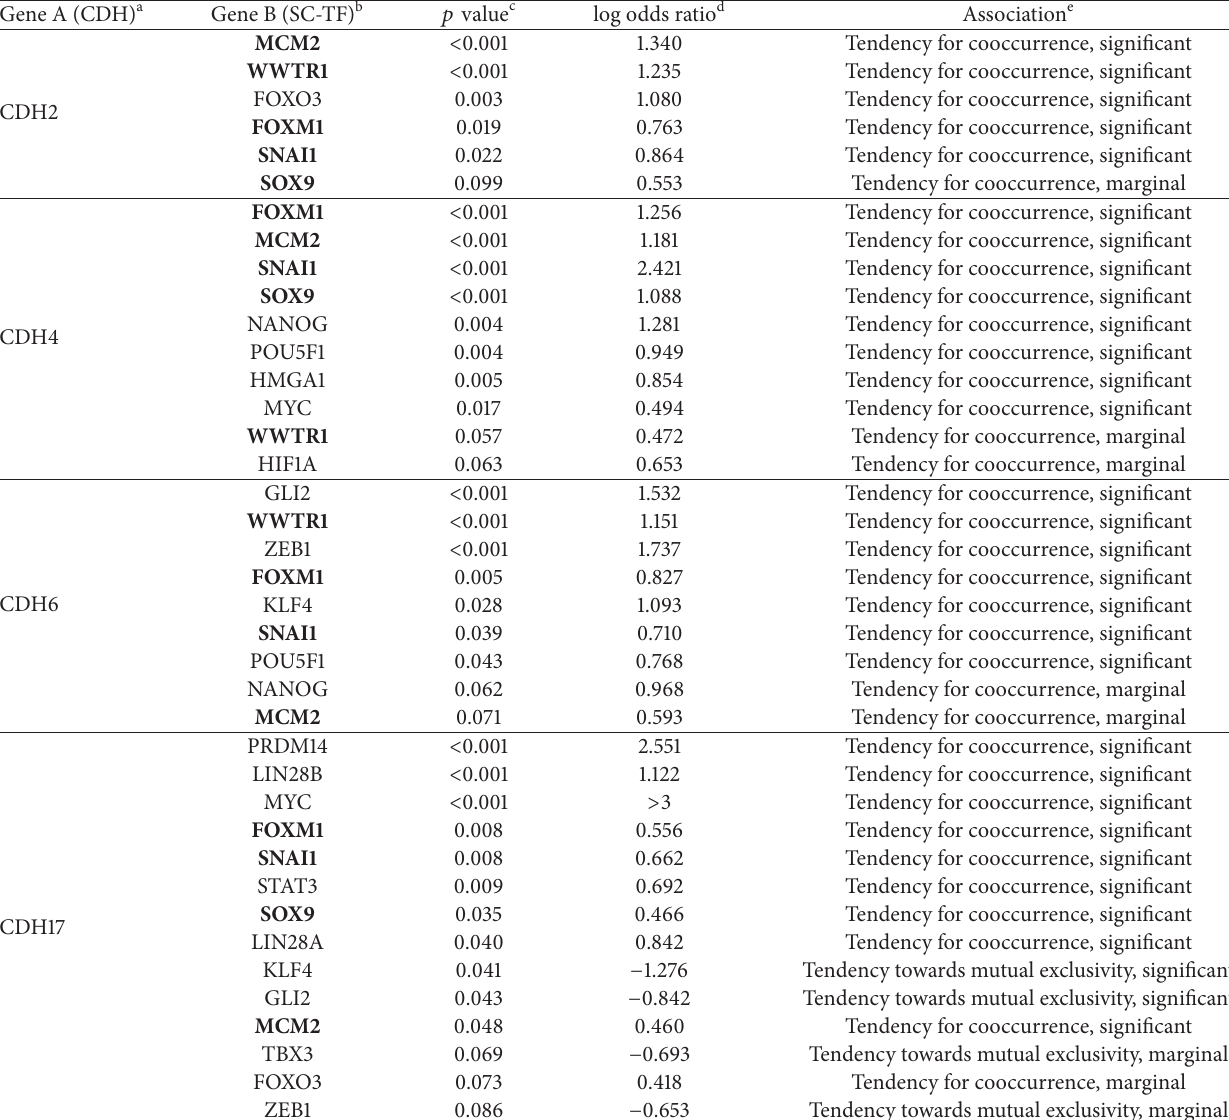
Table 1: Cooccurrence of stem cell-related transcription factors in association with alterations of CDH2, 4, 6, and 17. Gene A (CDH) a